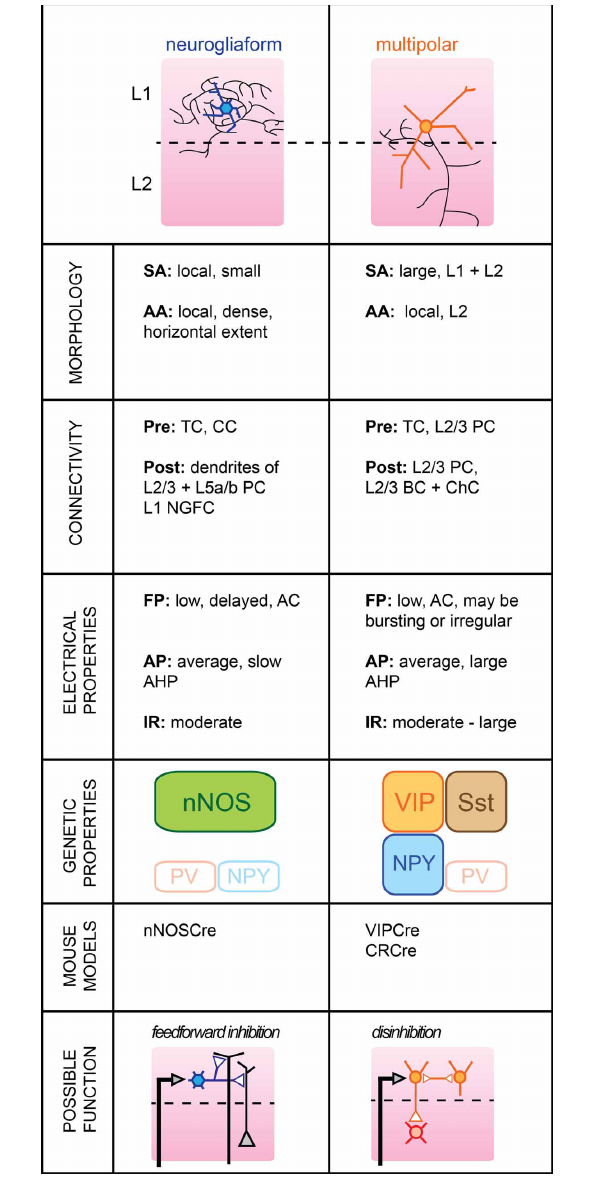
FIGURE 1 | Subtypes of cortical GABAergic neurons in layer 1. Top : schematic representation of neuronal morphology. Thick colored lines: somatodendritic arborization; thin black lines: axonal arborization. Abbreviations per row. Morphology, SA , somato-dendritic arborization; AA , axonal arborization. Connectivity, Pre , presynaptic source; Post , postsynaptic target; TC , thalamocortical afferents; CC , corticocortical afferents; PC , pyramidal cell; NGFC , neurogliaform cell; BC , basket cell; ChC , chandelier cell. Electrical properties, FP , firing pattern; low , < 100Hz maximal firing rate; moderate , 100–150 Hz; high , > 150Hz; AC , accommodating; AP , action potential; AHP , after-hyperpolarization; IR , input resistance. Genetic properties (filled top boxes: expressed markers; bottom empty boxes: markers not expressed), nNOS , neuronal nitric oxide synthase; NPY , neuropeptide Y; PV , parvalbumin; VIP , vasoactive intestinal polypeptide; Sst , somatostatin. Bottom : schematic representation of possible functional role within the local circuit. Black arrows indicate excitatory inputs; reversed white triangles represent inhibitory